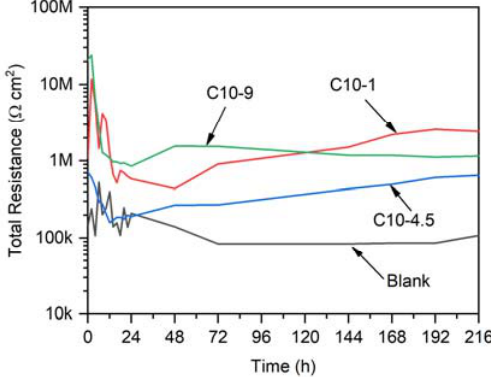
Figure 12. Evolution of the total resistance over 216 h of immersion.